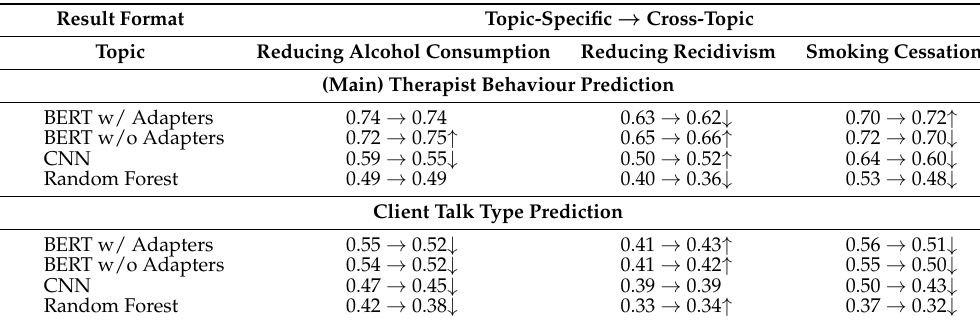
Table 17. Topic-specific and cross-topic performance (macro F1) in the Original Unbalanced setting for (1) therapist behaviour prediction and (2) client talk type prediction. The 3 topics are reducing alcohol consumption, reducing recidivism, and smoking cessation. ↑ / ↓ : cross-topic performance is higher/lower than topic-specific